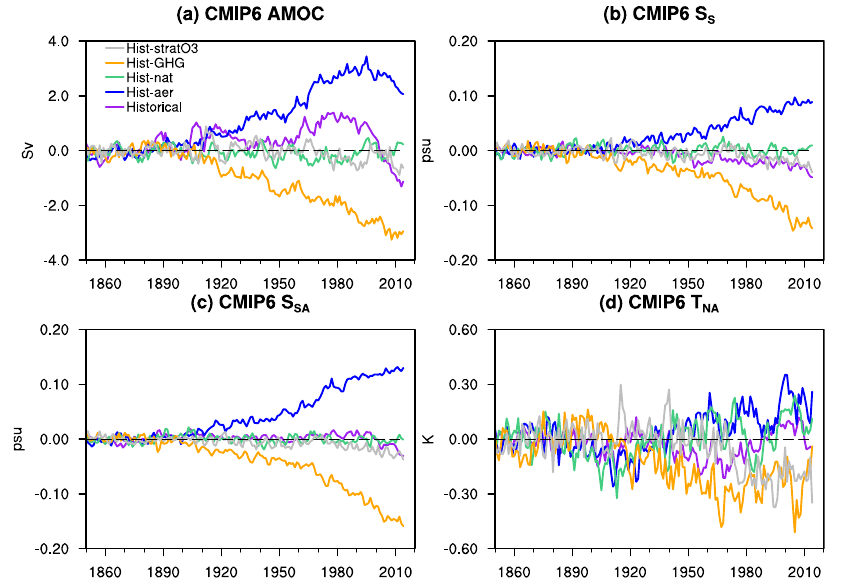
fi ngerprint S fi ngerprint T SA ( c ) and warming hole NA ( d ) in CMIP6 historical (pur- ple), Hist-aer (blue), Hist-nat (green), Hist-GHG (orange) and Hist-stratO3(gray) simulations. Anomalies are relative to the means of 1850 –